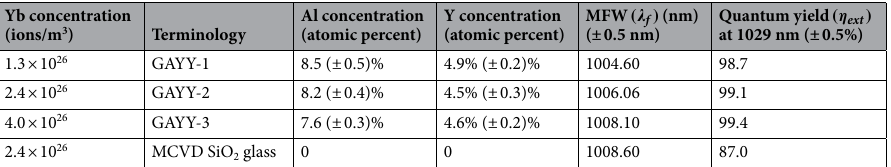
Table 1. The Yb ion concentration of investigated glasses along with the terminology used in the text, Al & Y concentration (in atomic percent), the mean fluorescence wavelength (MFW) & quantum yield at RT while exciting with 1029 nm laser with 5 W pump